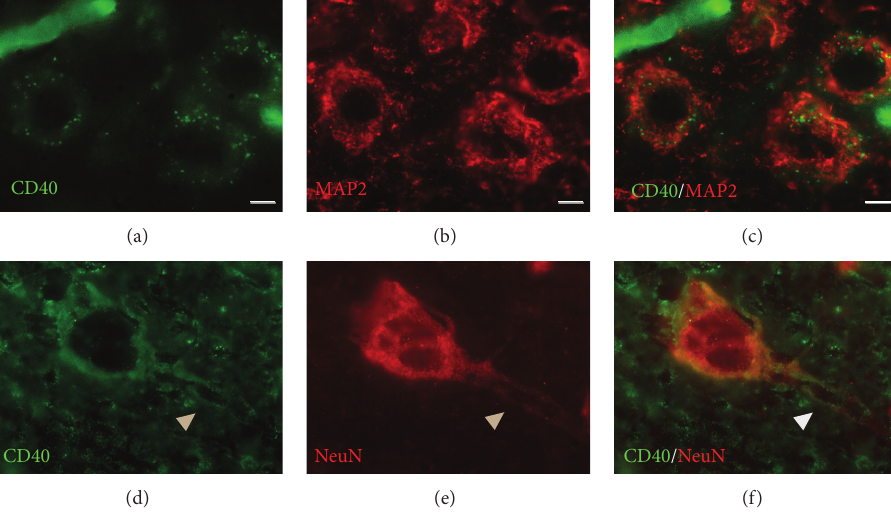
Figure 6: CD-40 (green fluorescence) colocalization with markers of neuronal cells in the injured cortex. ((a)–(c)) Double- immunofluorescence analysis of CD40 (a) and MAP-2 ((b) red fluorescence) revealed that CD40 fluorescence signal was mostly detected on neuronal cell bodies ((c) yellow fluorescence). ((d)–(f)) CD40 (d) and NeuN ((e) red fluorescence) fluorescence colocalized not only on neuronal cell bodies but also on axons (f). Arrow head points to varicosities along axons. Scale bar = 5 𝜇